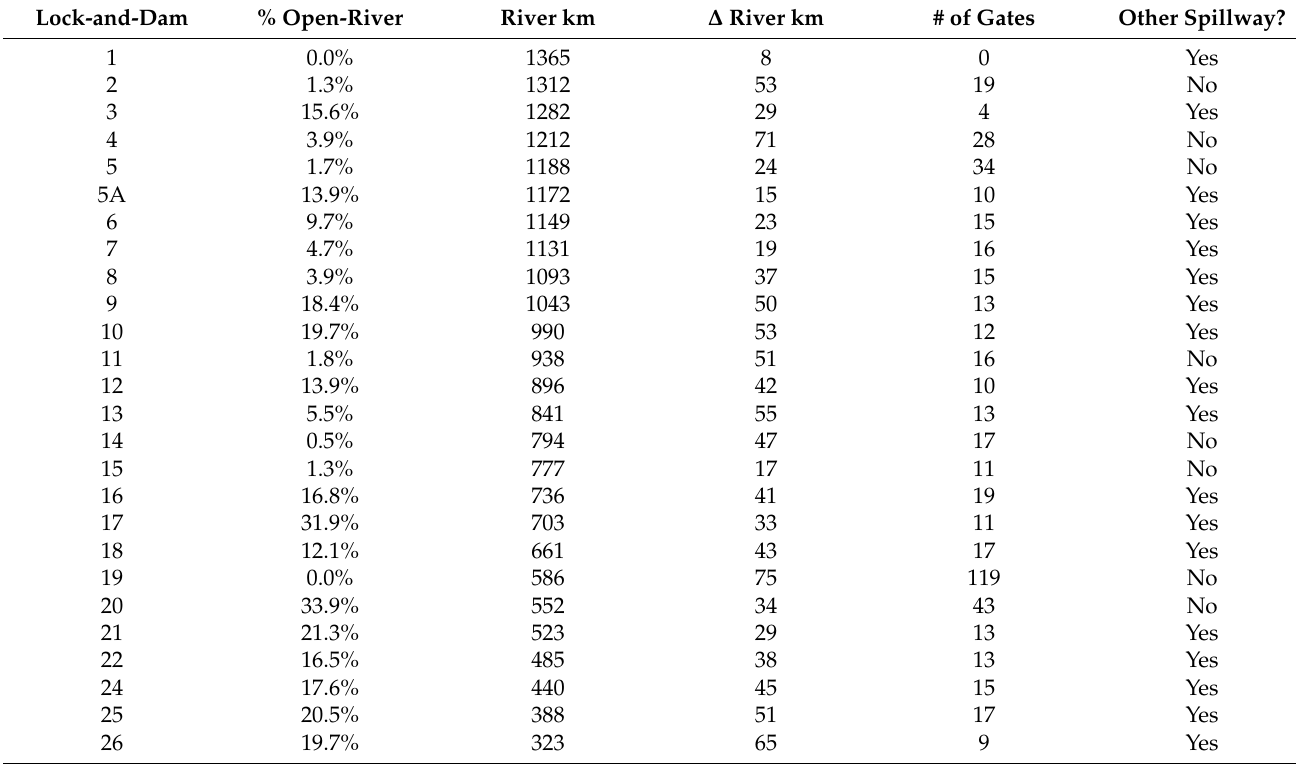
Table 1. Summary of locks-and-dams (LDs) in the Upper Mississippi River (UMR). The percent time spent in open-river was calculated from historical records between 1970–2000 [29]. ∆ River km is the distance (pool size) between that LD and the next one upstream [29]. The Upper and Lower Saint Anthony Falls Dam (upstream of LD 1 and lacking an operational lock) and Chain of Rocks Lock (downstream of LD 26) differ structurally from LDs 1–26 and are not included. The final column indicates whether the lock-and-dam has an additional uncontrolled overflow spillway that functions during high flow conditions. Consecutive LDs that experience open-river conditions less than 5% of the time are shaded. Two LDs that do not go into open-river (0%), because they do not have spillway gates are also shown (LD 1, LD 19).